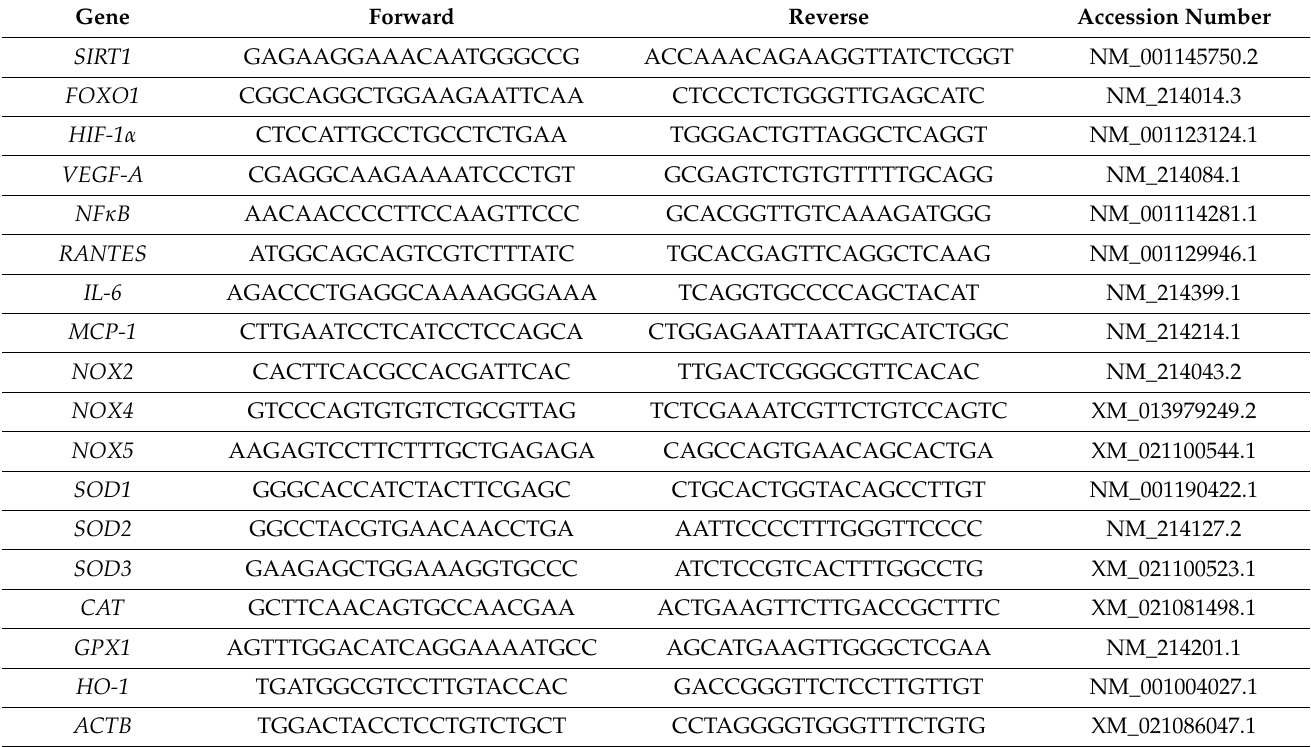
Table 1. Primer sequences used for